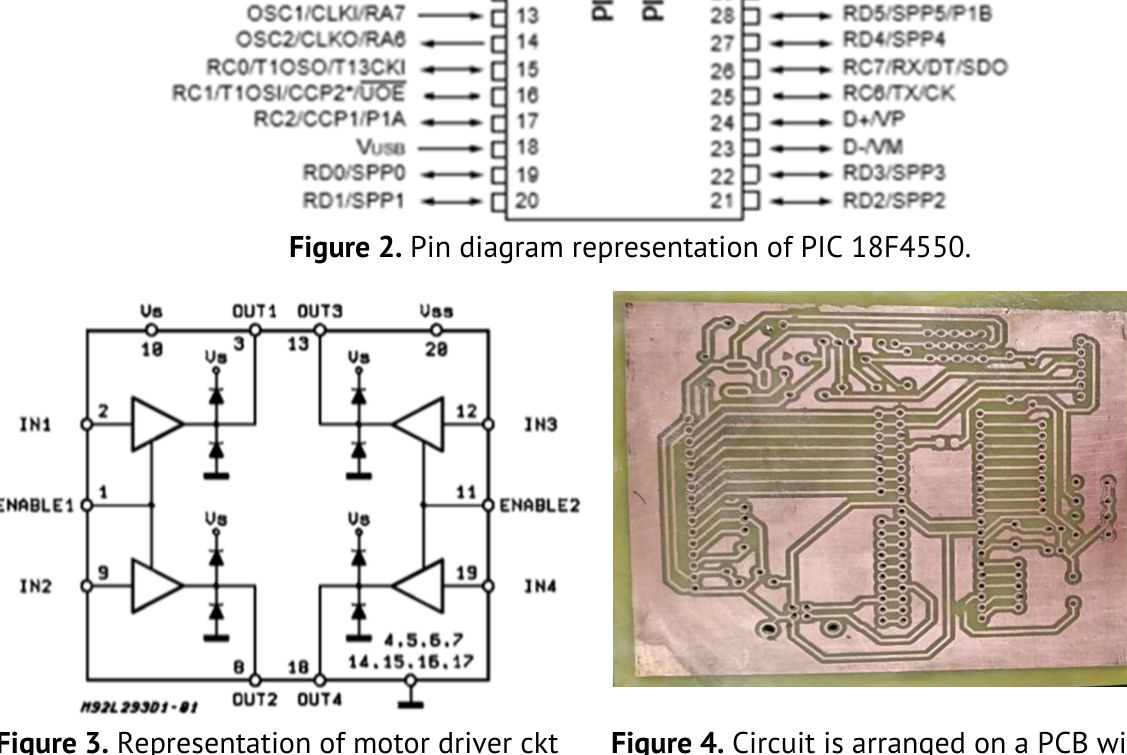
Figure 4. Circuit is arranged on a PCB with copper